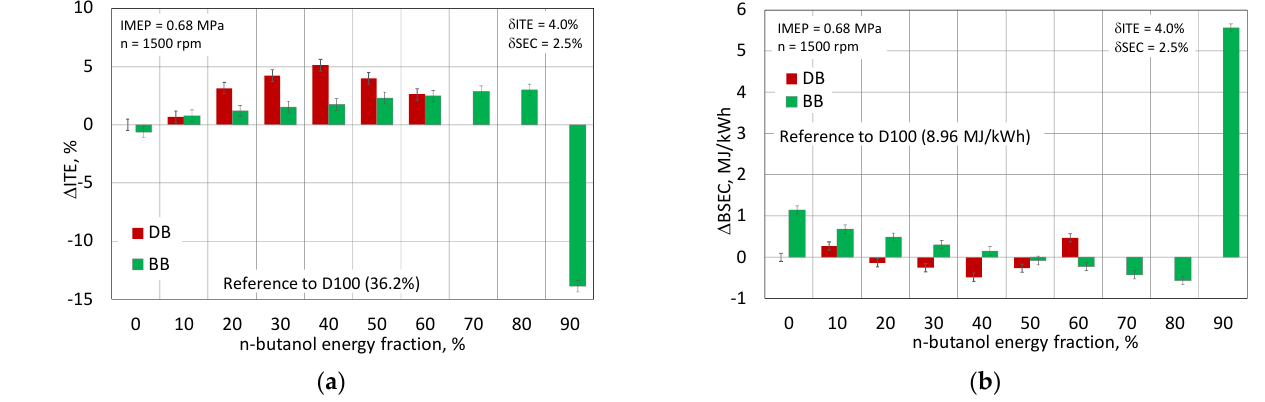
Figure 17. Engine indicated efficiency ( a ) and specific energy consumption ( b ).